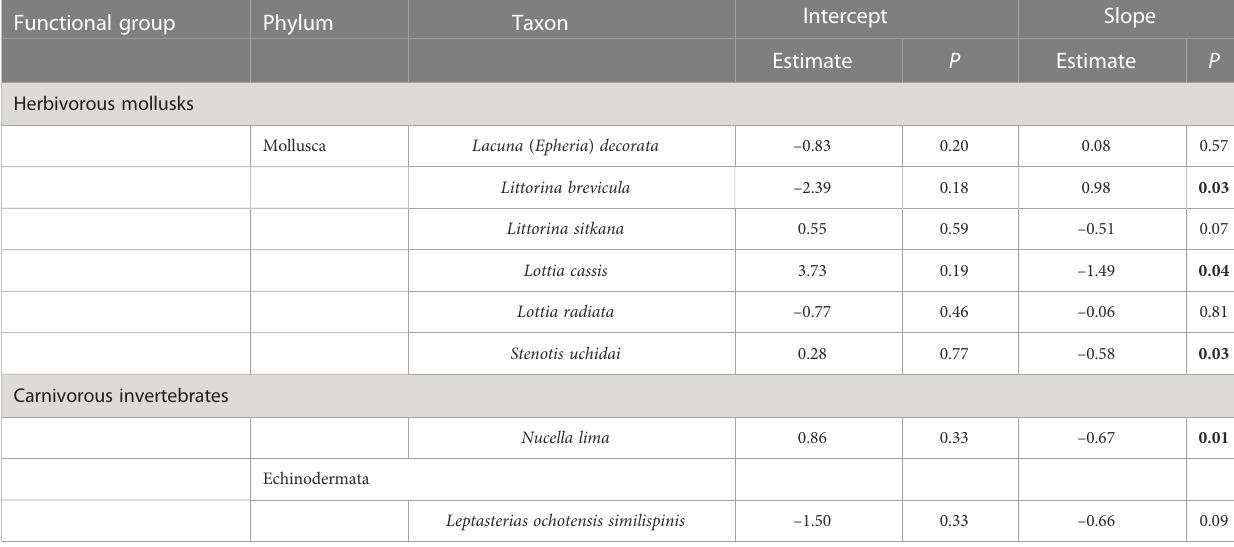
TABLE 2 Accumulative carryover effects on the abundances of eight mobile species. Functional